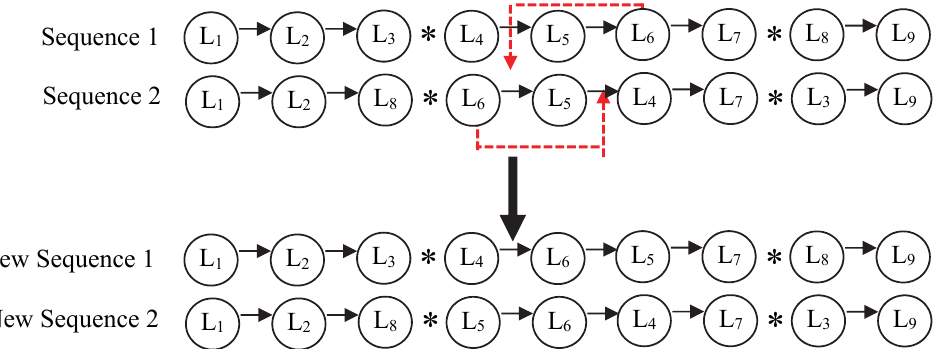
Fig. 5. Shifting mutation